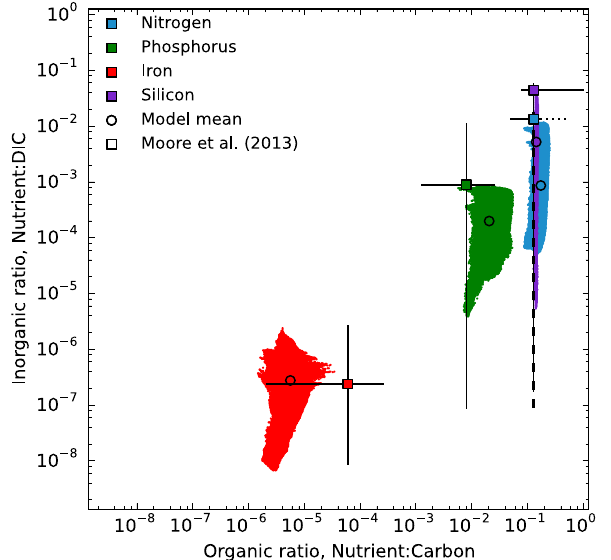
Figure 7. A comparison of the ratio of each modelled nutrient to carbon ratio in organic matter against the dissolved inorganic nutri- ent to carbon ratios. This figure shows a colour-coded distribution of the modelled nitrogen, phosphorus, iron and silicon to carbon ratios. The model distribution means are indicated by circular markers, and the typical in situ value and observed range from Moore et al. (2013) are shown as square markers with horizontal bars. The ver- tical bars associated with the square markers were calculated from World Ocean Atlas data (Garcia et al., 2010) and GEOTRACES (Henderson et al., 2007).